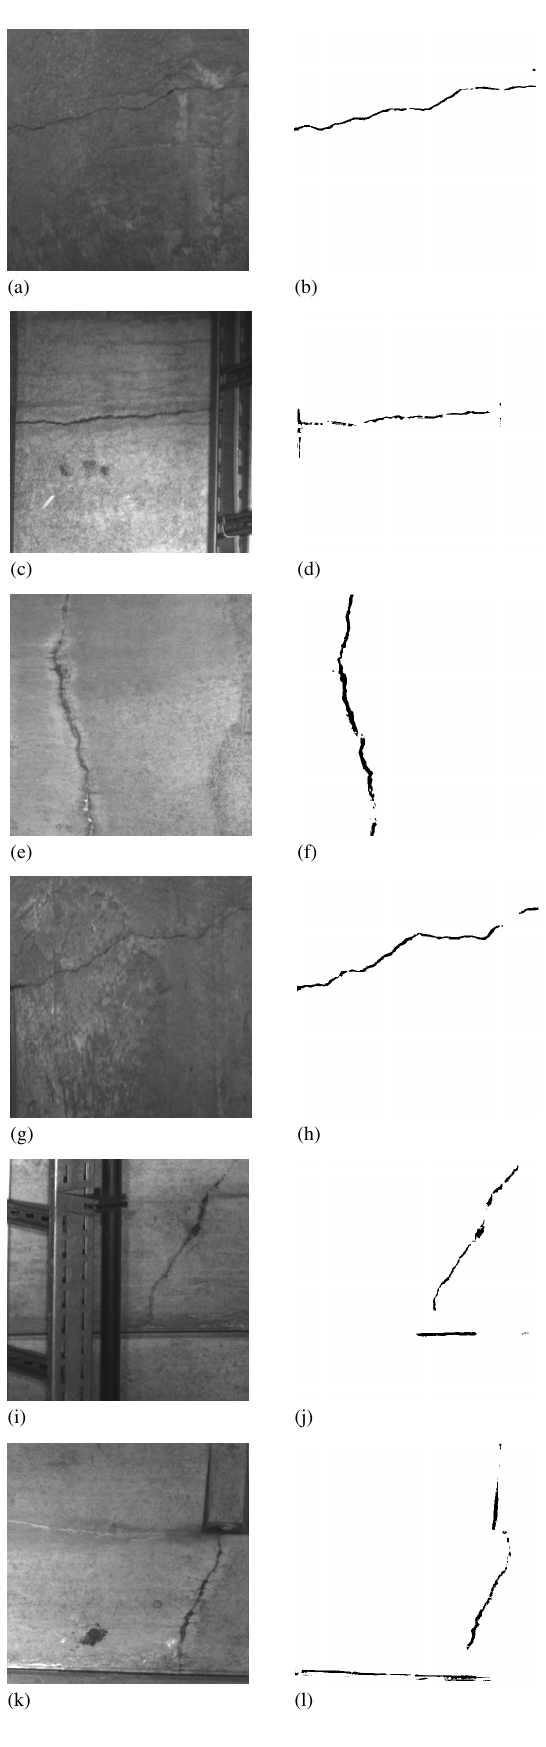
Figure 3. Crack segmentation results for the tunnel dataset provided by